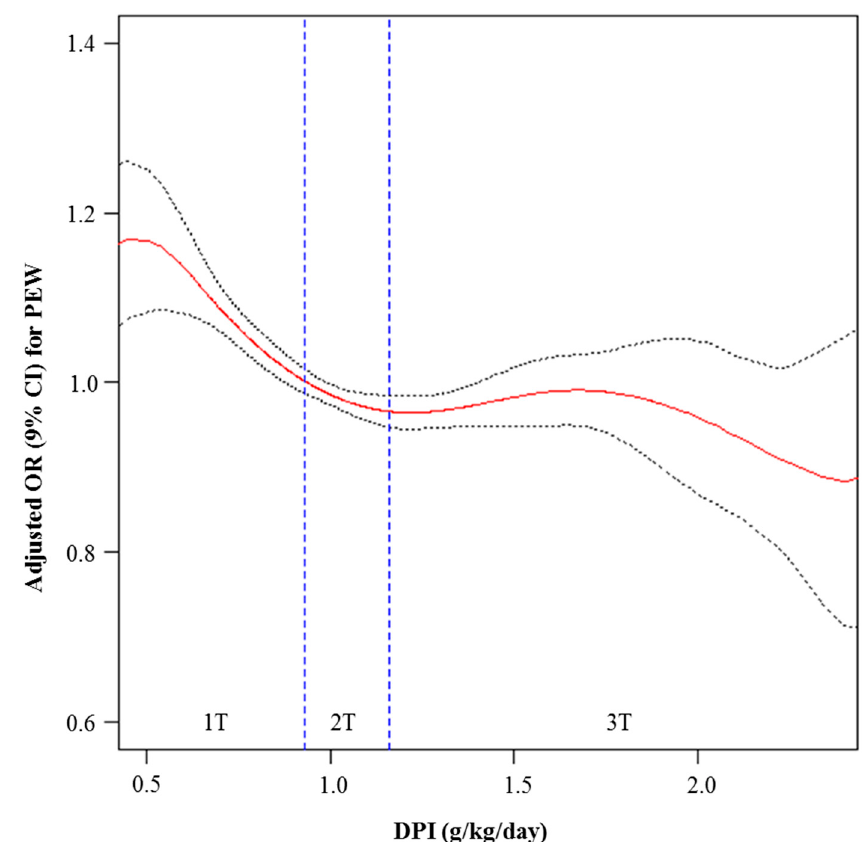
Figure 3. Penalized smoothing splines showing the relationship between DPI and PEW. DPI, dietary protein intake; PEW, protein energy wasting; OR, odds ratio; CI, confidence interval; T, tertile. The upper ( ≥ 2.36 g/kg/day) and lower 1% (<0.5 g/kg/day) of DPI were truncated. The red line indicates the OR and the black dotted line indicates the 95% CI for which DPI influences PEW components by three or more. OR and 95% CI were analyzed using a multivariate logistic regression analysis including age, sex, current smoking, alcohol drinking, hypertension, diabetes, causes of chronic kidney disease, urine protein to creatinine ratio, blood urea nitrogen, estimated glomerular filtration rate, bilirubin, hemoglobin, and high sensitivity C-reactive protein.